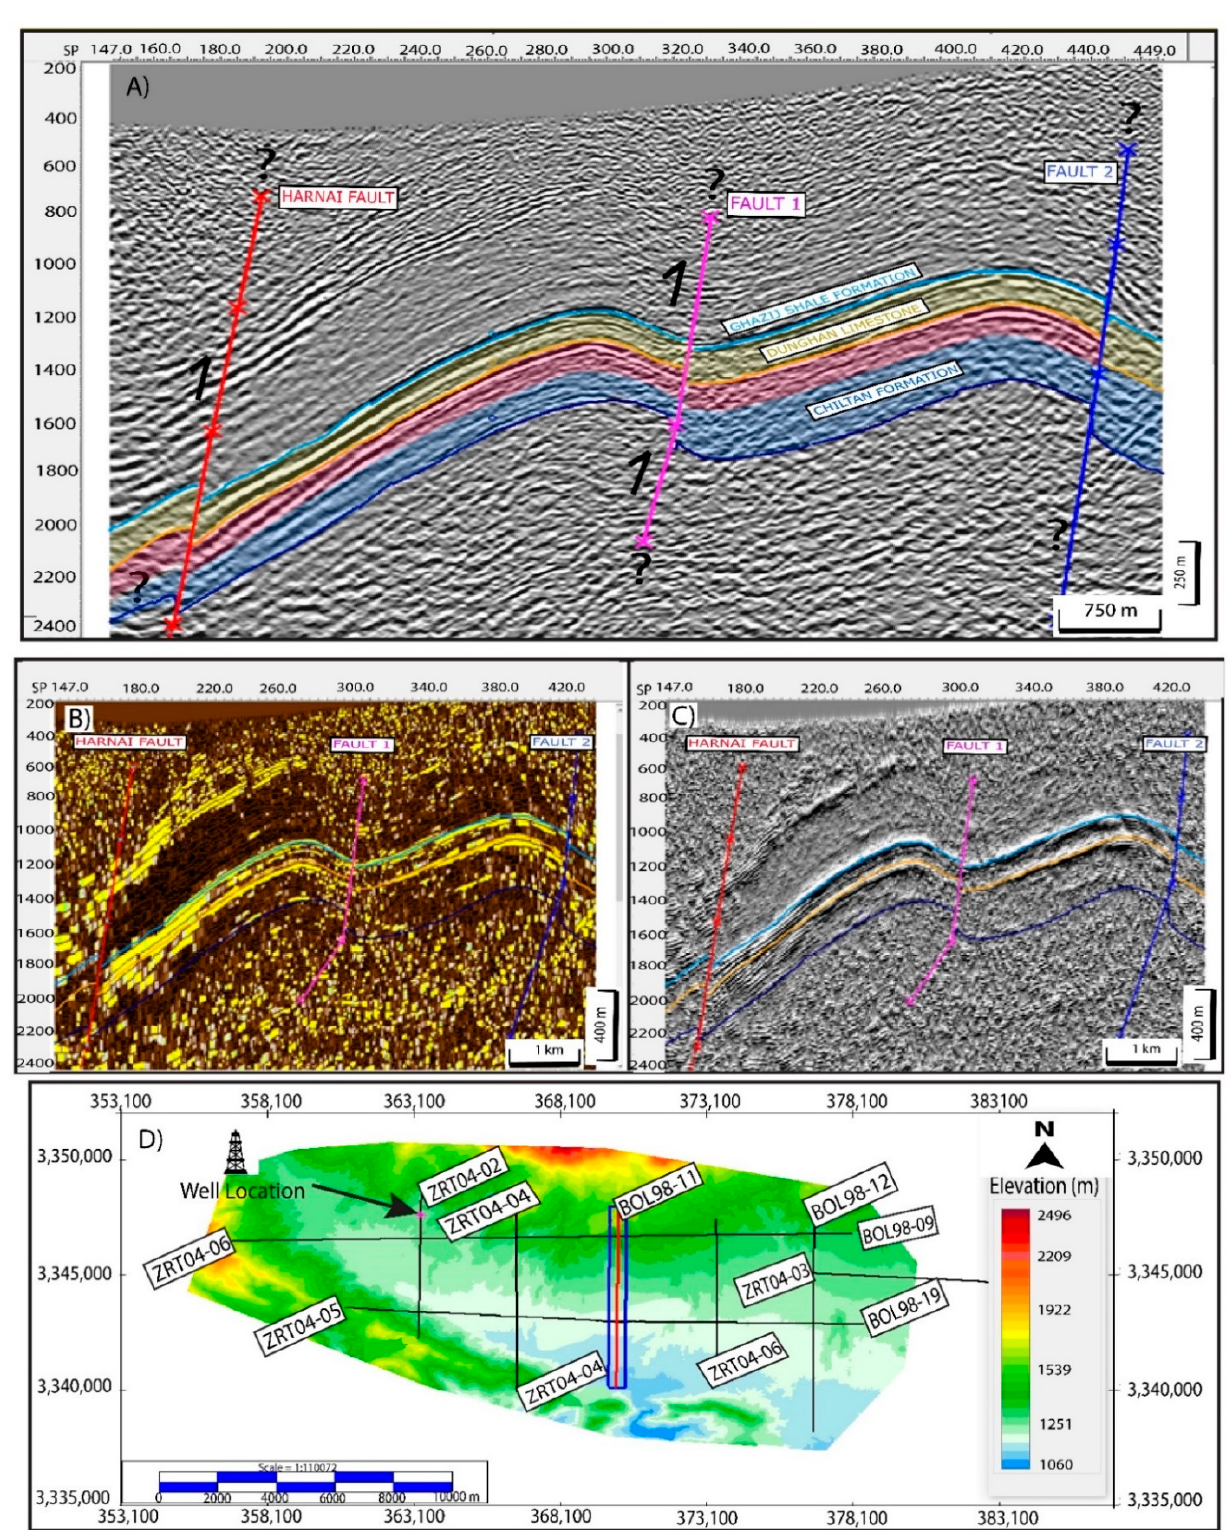
Figure 12. Interpretation of seismic line BOL98-11. ( A ) represents an interpretation of BOL98-11 seismic section. ( B ) and ( C ) show the seismic attributes with Envelope and Pseudo-relief, respectively. ( D ) shows the location of the seismic section BOL98-11, and the color bar shows the elevation.